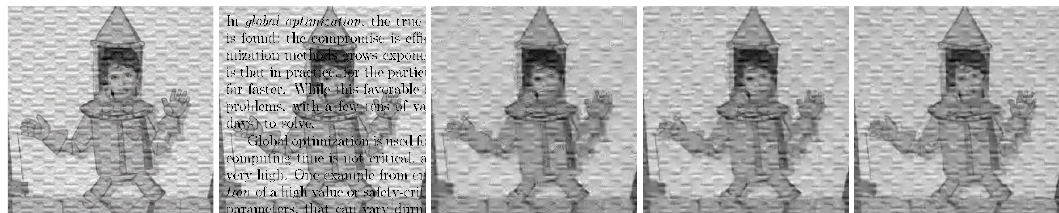
Figure 8. Visual quality comparison of text image inpainting results. From left to right: Original image, text image, result of DCT ( PSNR = 27.11), KSVD ( PSNR = 28.01) and our SSM-NTF method ( PSNR = 28.95), respectively.